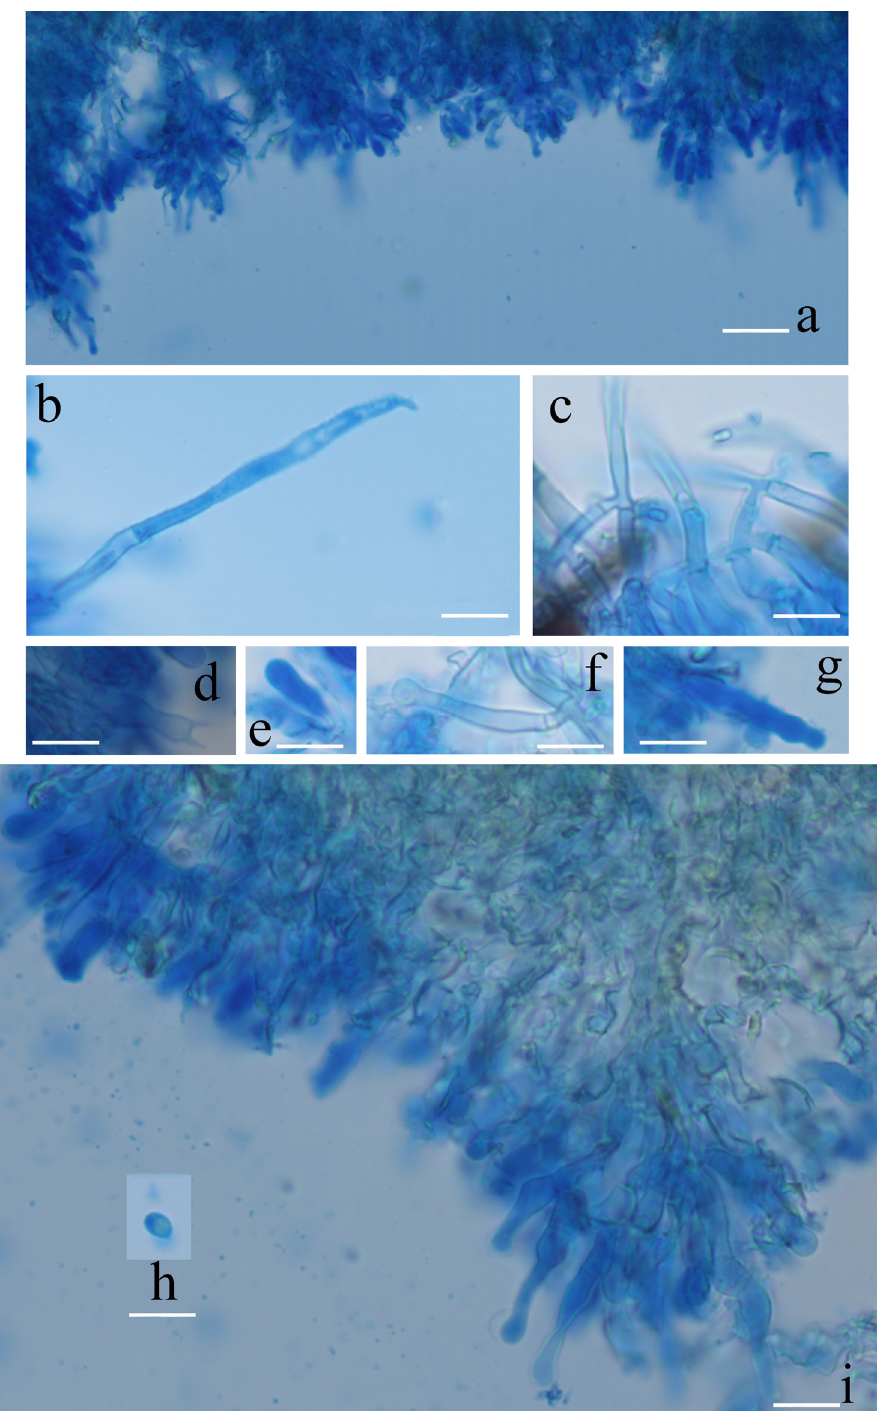
Figure 4. Microscopic structures of Xylodon gossypinus (holotype) ( a ): a section of hymenium ( b ), subulate cystidia to leptocystidia ( c ), generative hyphae ( d ), basidia ( e ), basidioles ( f ), capitate cystidia ( g ), moniliform cystidia ( h ), and basidiospores ( i ). A section of hymenium. Bars: ( a – i ) = 10 µ m, ( a ) 10 × 40, ( b – i ) 10 × 100 Larss. and X. septocystidiatus (H.X. Xiong, Y.C. Dai & Sheng H. Wu) Riebesehl & Langer based on the character of the thick-walled basidiospores. However, Xylodon anmashanensis is distinguished from X. gossypinus by having the irpicoid to odontioid hymenial surface and longer basidiospores (up to 7.5 µm long) [13]; X. crassisporus differs from X. gossypinus by having only one type of capitate cystidia and wider basidiospores